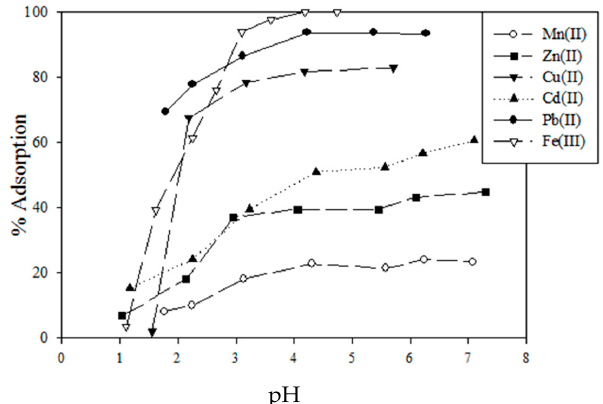
Figure 13. % adsorption (A) of some metal ions by SOJR at different equilibrium pH values [14]. (Copyright 2003 by The Minerals, Metals & Materials Society. Reprinted with permission).